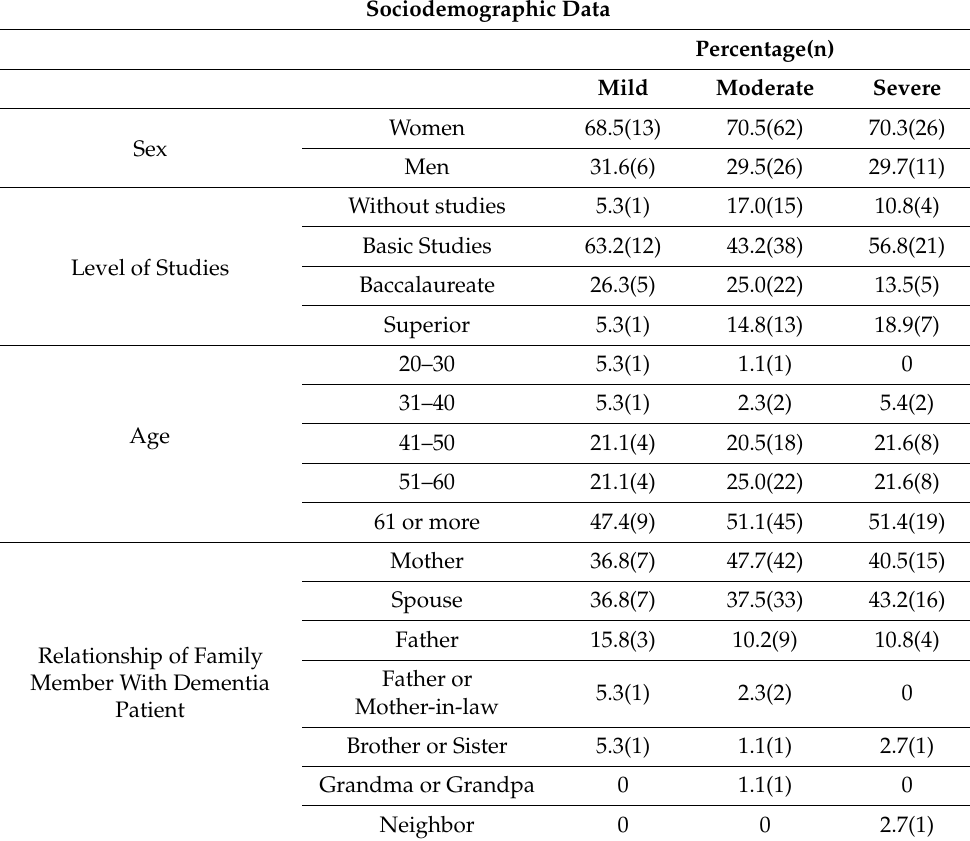
Table 1. Demographic outcomes by severity